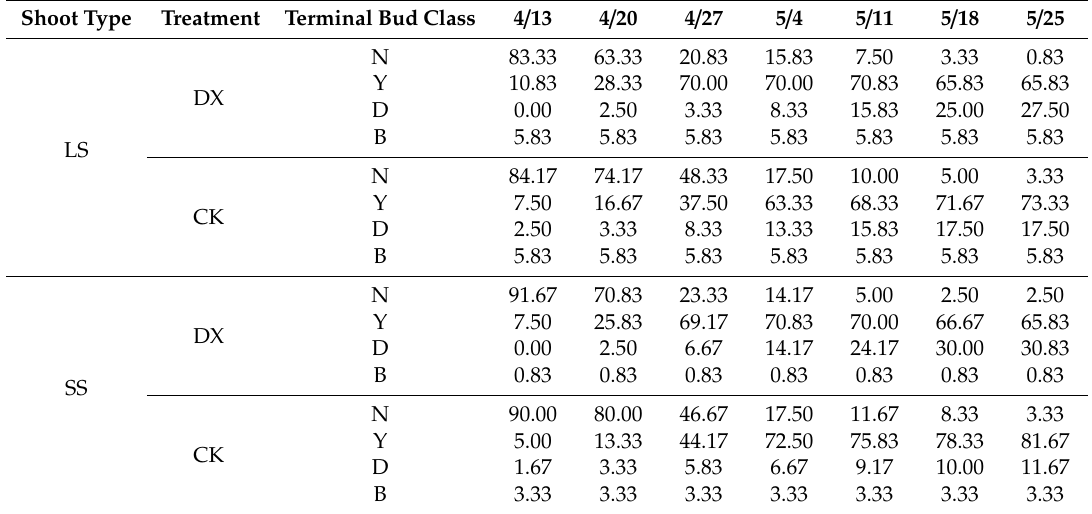
Table 2. Changes of weekly percentage (%) of the four terminal bud classes on seven dates z . Shoot